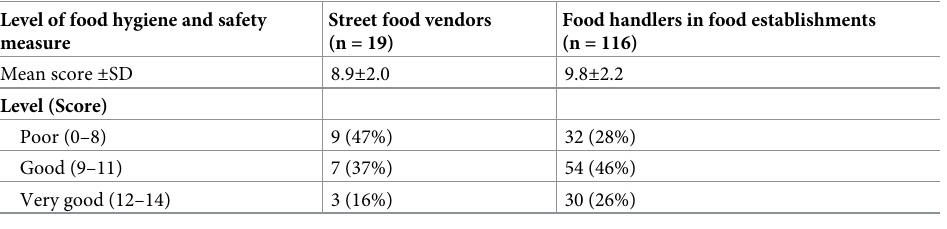
Table 2. Compliance score of the level of food hygiene and safety measures among street food vendors and food handlers in food establishments from December 2013 to June 2014, Dessie town,